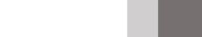
Figure 32. ( a ) Radio absorption and ( b ) reflection coefficients of composite materials based on metal- containing nanoparticles. Figure 33. Scheme of the formation of a two-layer combination of samples: (1) base sample Co-03 and (2) additional sample.